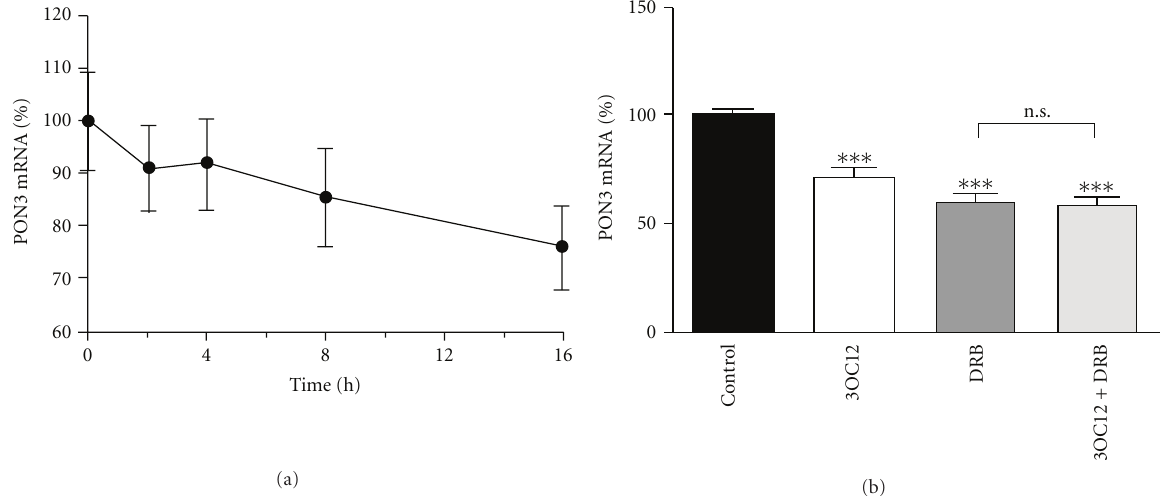
Figure 5: PON3 mRNA is not actively degraded in response to 3OC12 treatment. (a) A549 cells were treated with 3OC12 (100 μ M) for the indicated durations and analyzed for PON3 mRNA levels by qRT-PCR. (b) A549 cells were treated with 3OC12 (100 μ M, 24h) or with DRB (100 μ M, 24 h) or combinations thereof. There was no statistically significant di ff erence in PON3 mRNA levels after DRB or DRB/3OC12 treatment. Symbols represent ± S.E.M. n = 3; ∗∗∗ P < 0 . 001 versus